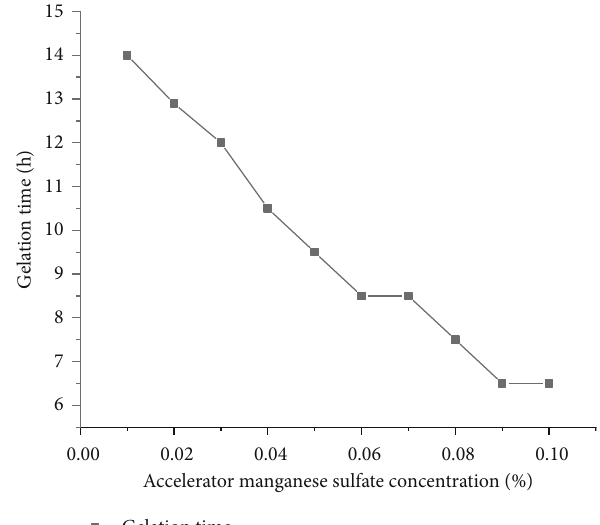
Figure 14: The e ff ect of accelerator concentration on the gel- forming e ff ect of the